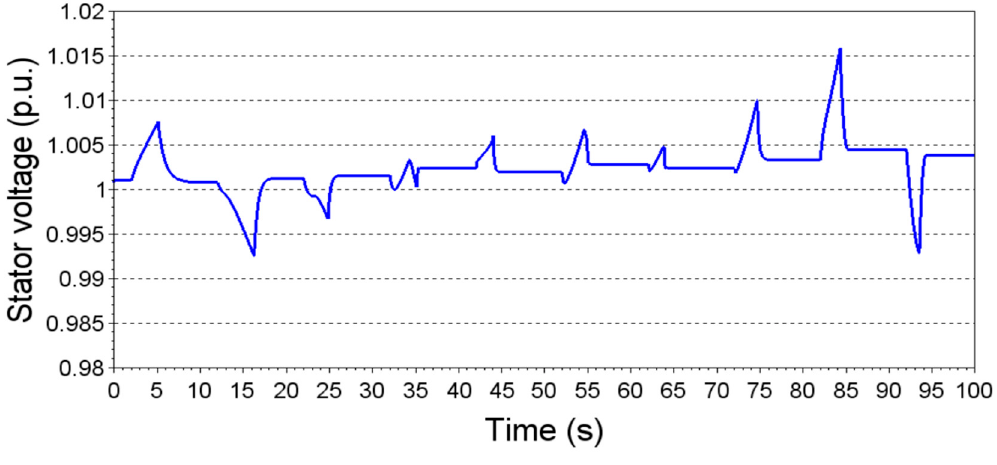
Figure 11. Stator voltage.